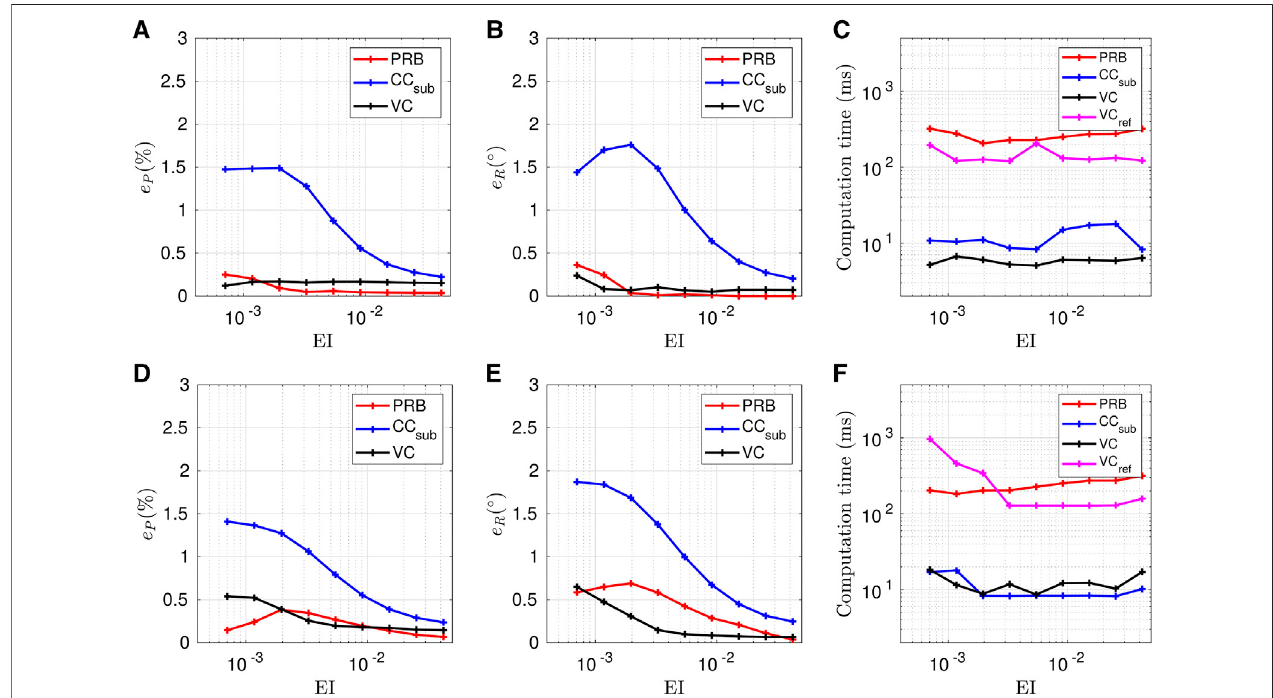
FIGURE 11 | Evolution of the models accuracy according to the backbone stiffness when considering a planar (A – C) and transverse (D – F) tip force for n (cid:1) 10. The metrics e p and e R represent the deviation of the tip position and orientation